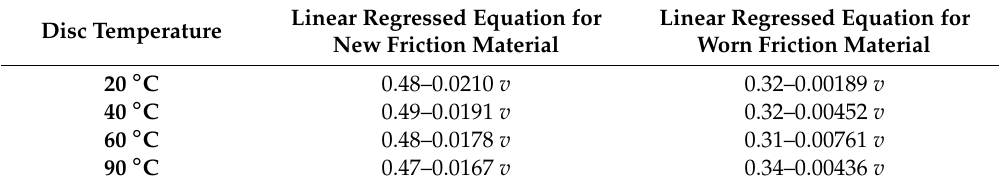
Table 1. Variation of the coe ffi cient of friction with slip speed, v , for new and worn clutch lining materials